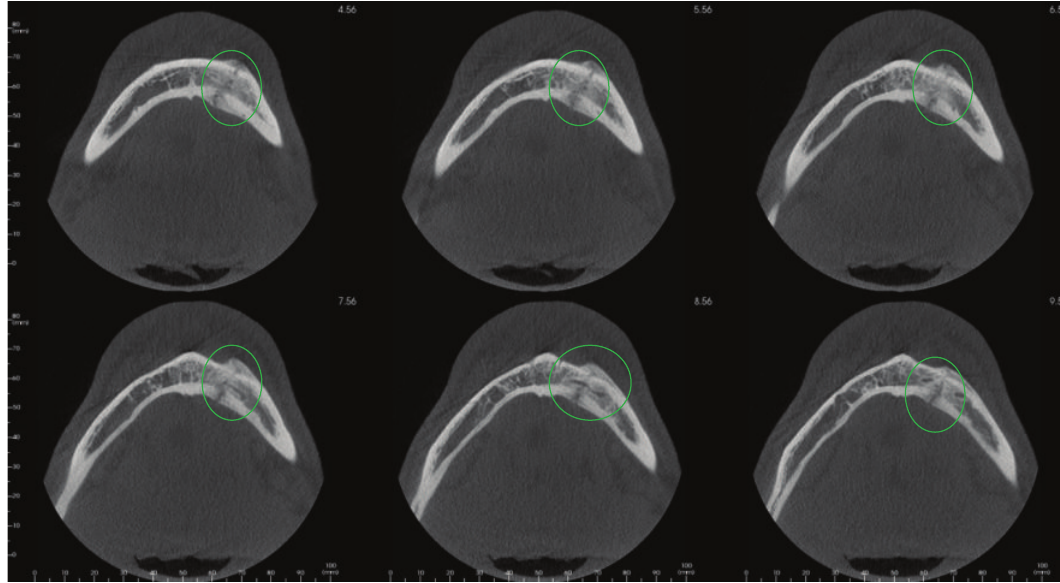
Figure 4: Axial view demonstrating osteomyelitic